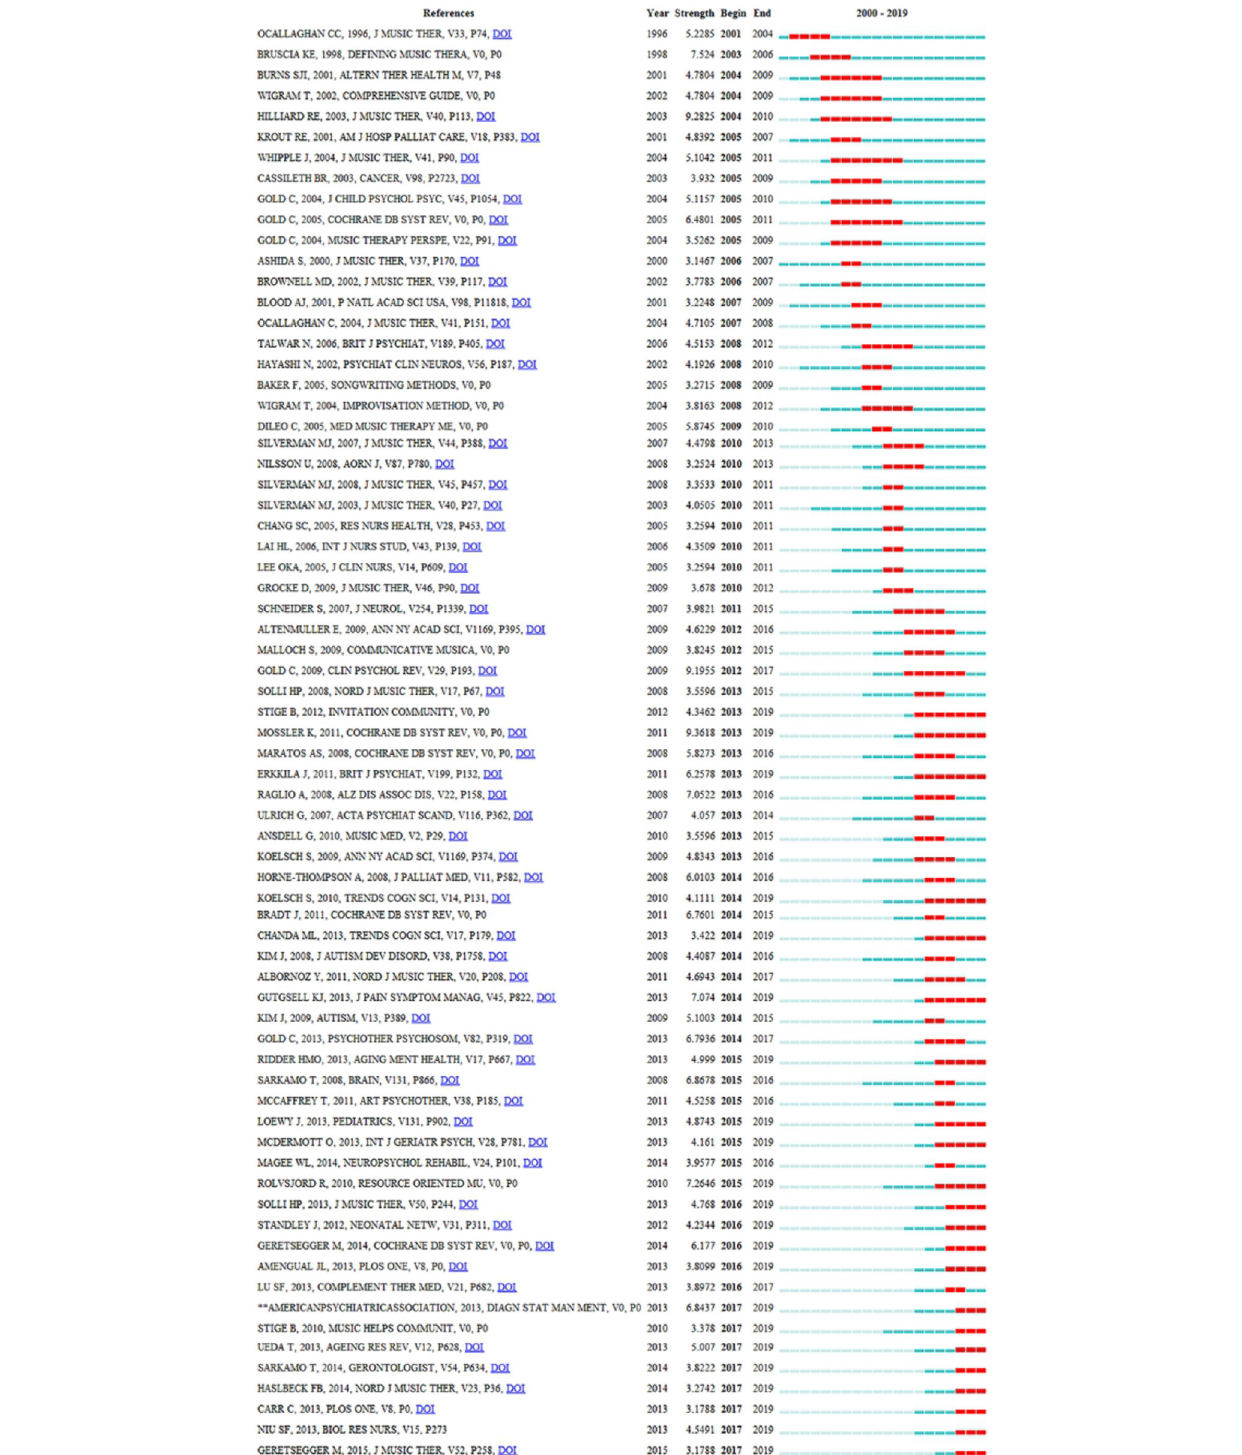
Frontiers in Psychology |